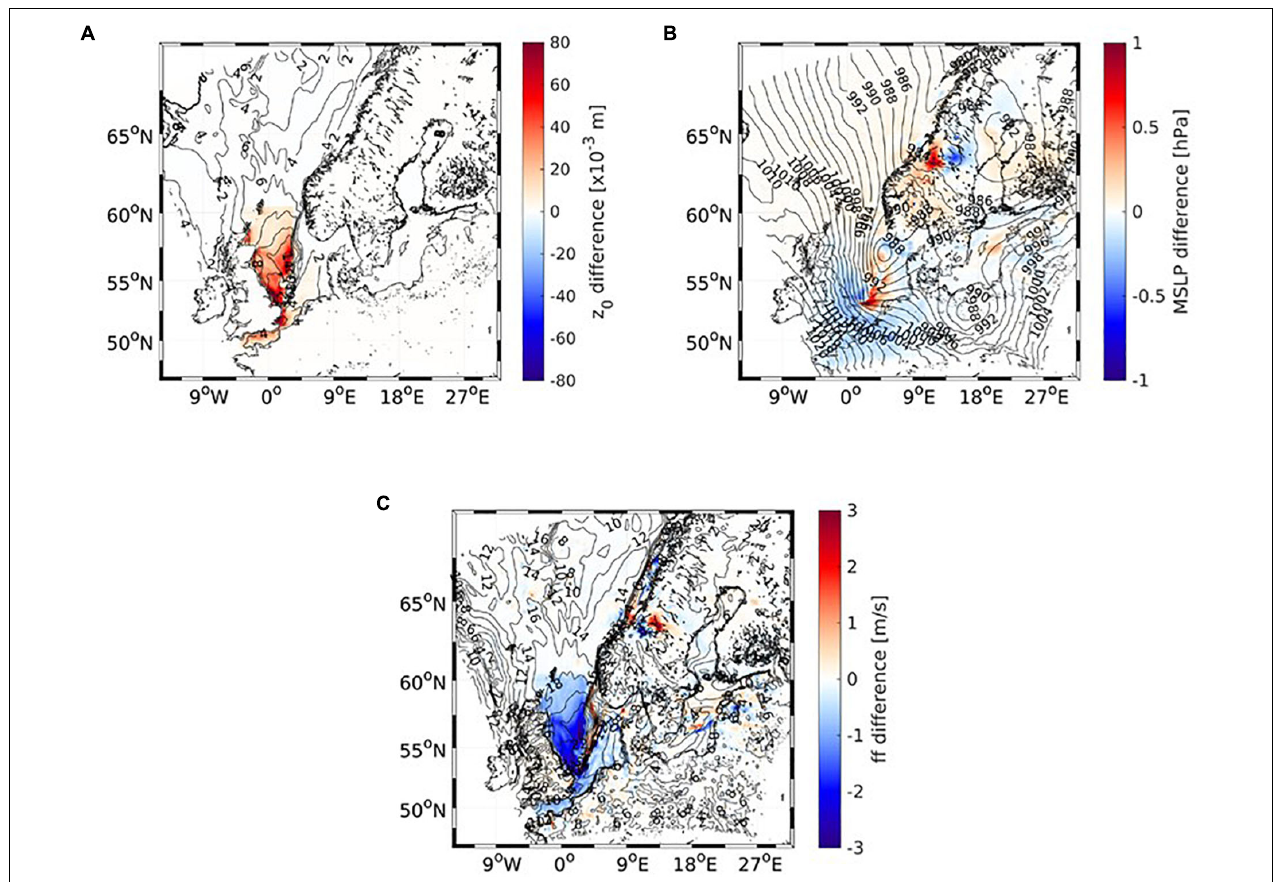
FIGURE 6 | Absolute values of roughness length variations (A) , mean sea level pressures MSLP (B) , and 10 m wind speed (C) for the regional stand-alone (reference) model simulations (contours). The color coding indicates the differences between the coupled and reference model simulations in the North Sea pilot domain during a sample storm on 13th January, 2017 at 12:00